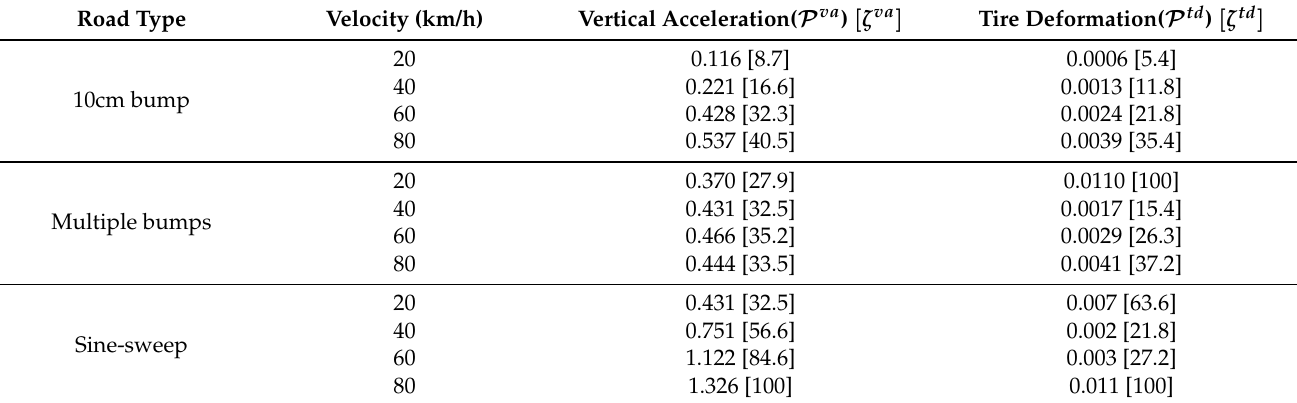
Table 2. Passive suspension simulation